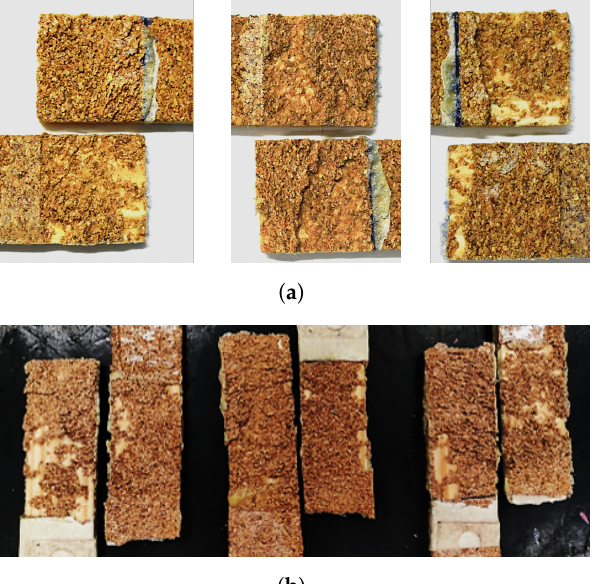
Figure 14. Failure mechanisms in WC joints. ( a ) A 25-mm overlap. ( b ) A 50-mm overlap.